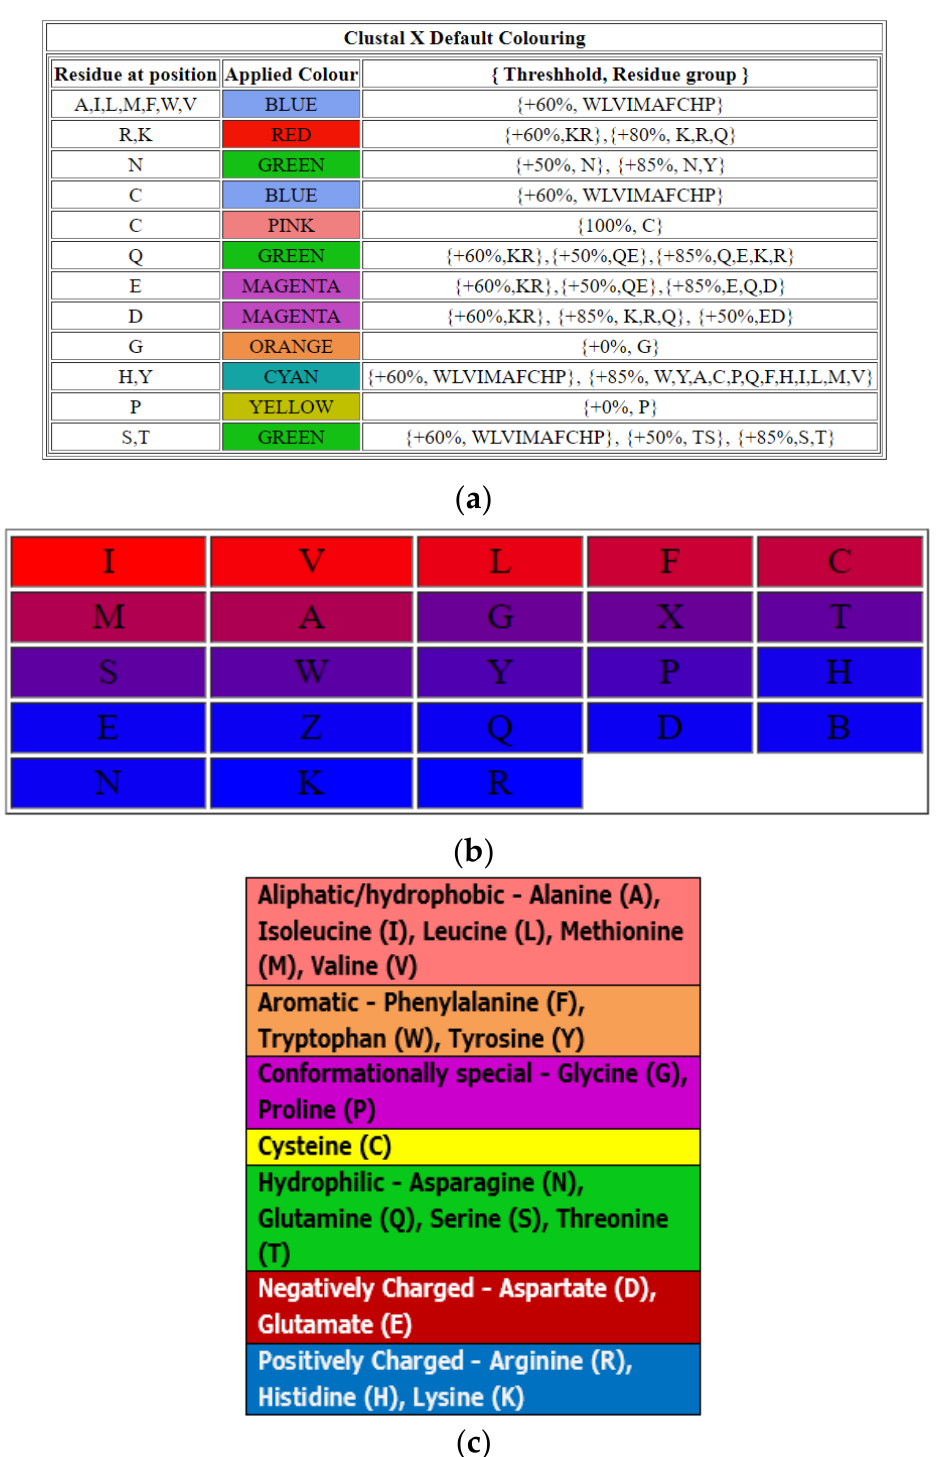
Figure A1. Alignment colorscheme: ( a ) CLUSTALX based on the threshold criteria and amino acid profile; ( b ) hydropathic character with the most hydrophobic residue being red, and blue being the most hydrophilic; ( c ) physicochemical character. Adapted from the documentation of Jalview [28].